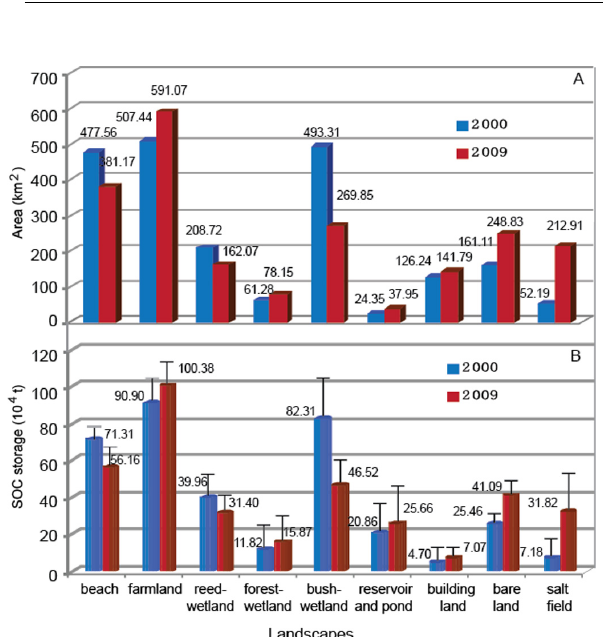
Fig. 3. Comparison of wetland landscape area (A) and SOC stor- age (B) in the Yellow River Delta from 2000 to 2009. Vertical bars represent standard error.